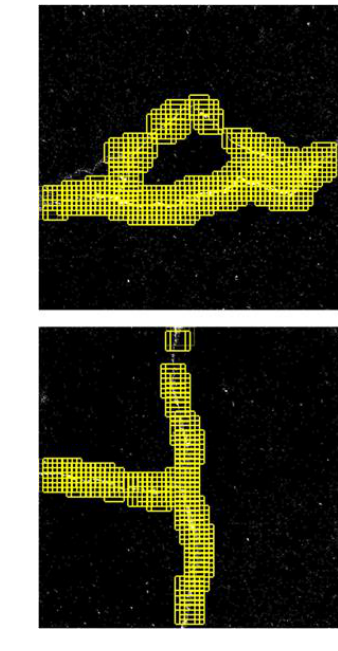
Figure 23. Results of crack position detection (CPD) based on ( a ) the original CPD and ( b ) the MLP– CNN, with uneven concrete surfaces.